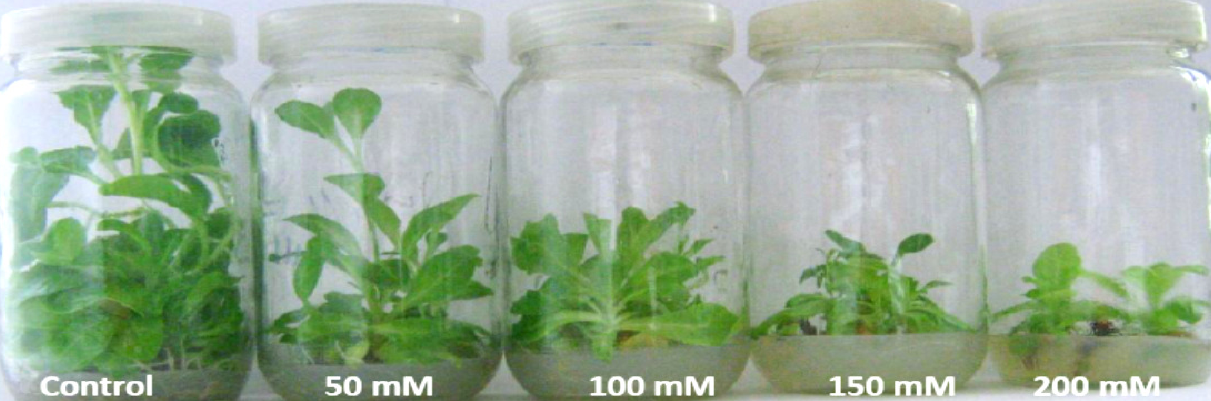
Fig. 1. Effect of gamma radiation doses on Nicotiana alata haploid plants survival in Nicotiana alata